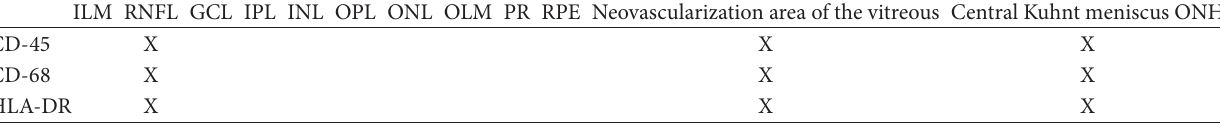
ONH: Optic nerve head.